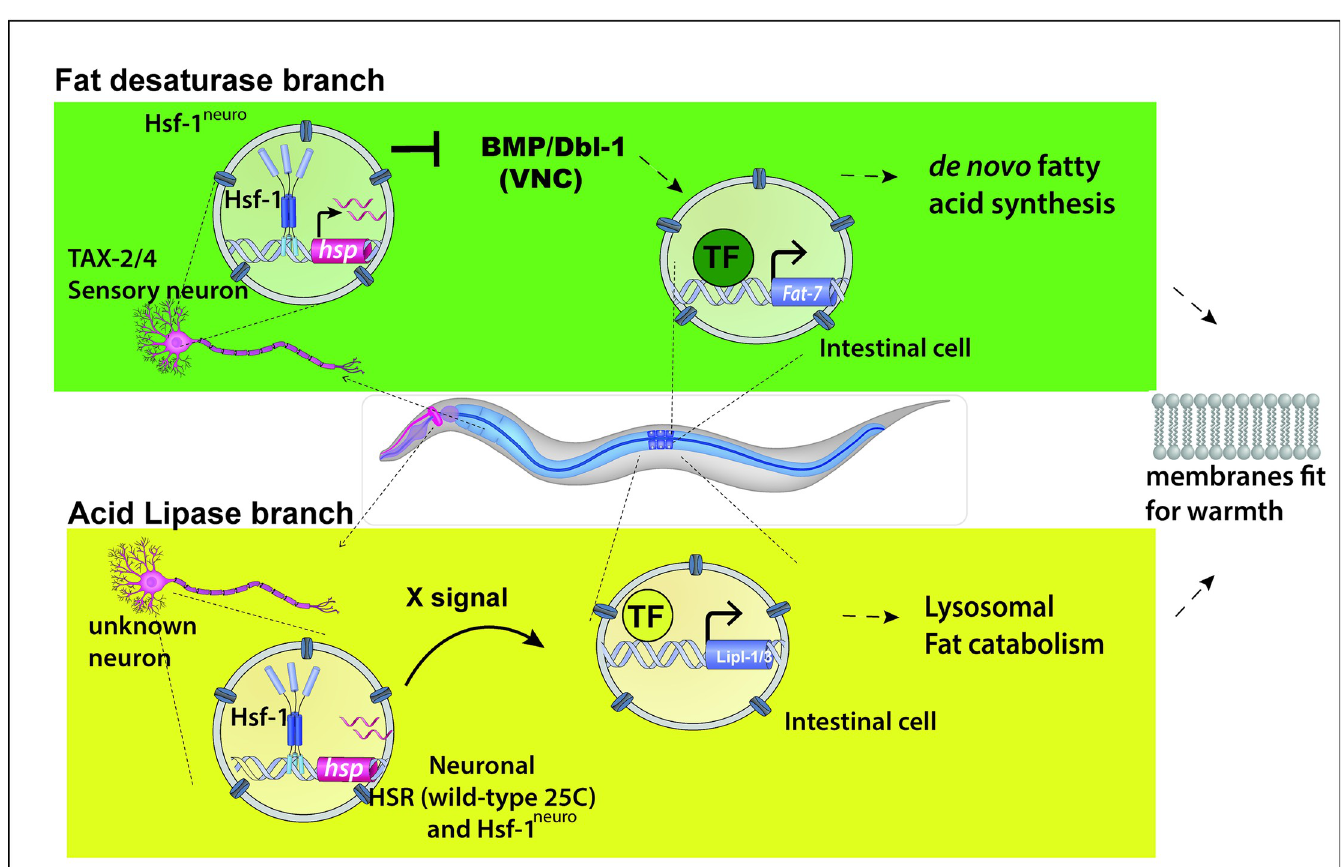
Fig 5. Diagram depicting the 2 branches of the fat remodeling program controlled by neuronal activation of Hsf-1. This diagram shows the image of an animal that has the “thermostat” turned on by hsf-1 neuro (in both branches) or by growing animals at 25˚C (only in the acid lipase branch). Fat desaturase branch: TAX-2/4– expressing neurons are sufficient but not necessary to control fat-6/7 expression in the gut. The neurohormonal TGF- β /BMP signal is down-regulated in the VNC neurons. In this model, the correct dose of BMP is key for Fat-6/7 expression in the gut and requires additional and redundant signals for fat-6/7 expression. Acid-lipase branch: HSF-1 is both necessary and sufficient to control this pathway. The HSF-1 thermostat works independently of TGF- β /BMP signaling pathway. The HSR is not required within TAX-2/4–expressing neurons, but presumably in other neurons that are in close proximity to them. Both the neurohormonal signals and TFs required for this pathway remain unknown. Both pathways are required for fat remodeling and survival at warmer temperatures. BMP, bone morphogenetic protein; HSF-1, heat shock factor 1; hsf-1 neuro , neuronal overexpression of hsf-1 ; HSR, heat shock response; TF, transcription factor; VNC, ventral nerve cord.